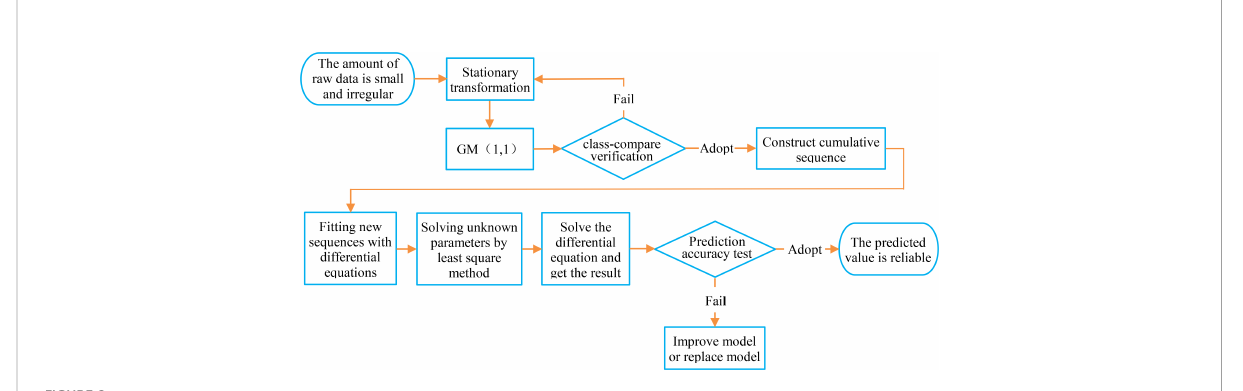
FIGURE 2 Application process of GM (1,1) grey prediction model.